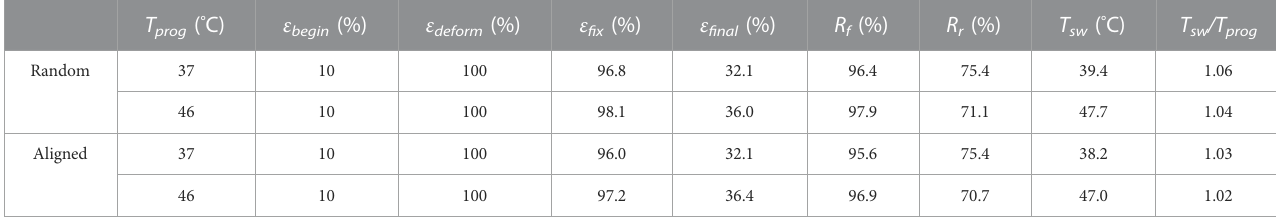
TABLE 4 Shape-memory properties of random and aligned determined in cyclic shape memory tests by DMA. T prog ( °